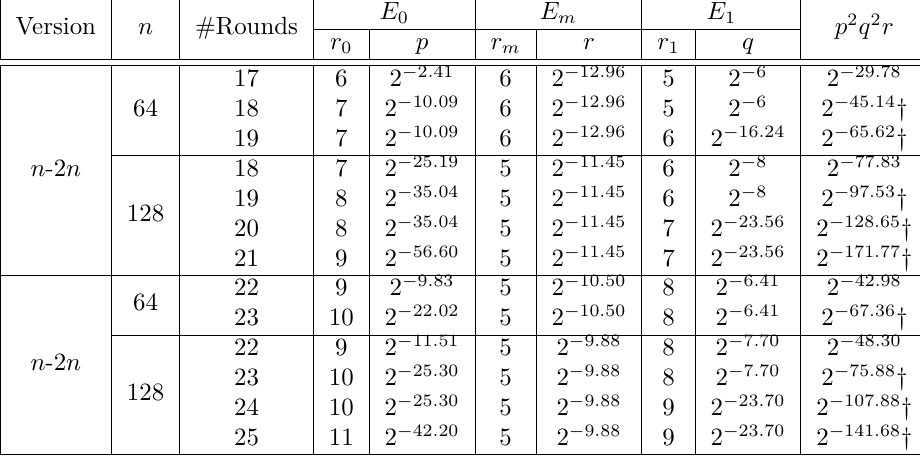
Table 17: Boomerang distinguishers for SKINNY proposed by [LGS17] and [SQH19]. The prob- abilities denoted by † , correspond to the distinguishers that are obtained by extending the distinguishers proposed in [LGS17] and